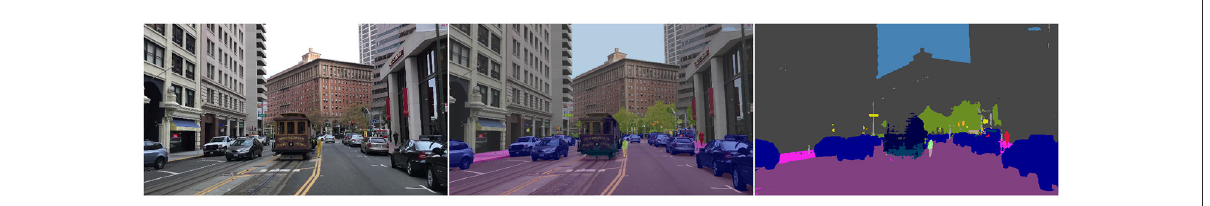
FIGURE4 Example input and output of the fastseg CNN (Eric, 2020). The network takes an RGB image as an input and outputs a segmented image with an annotation from 19 different categories.